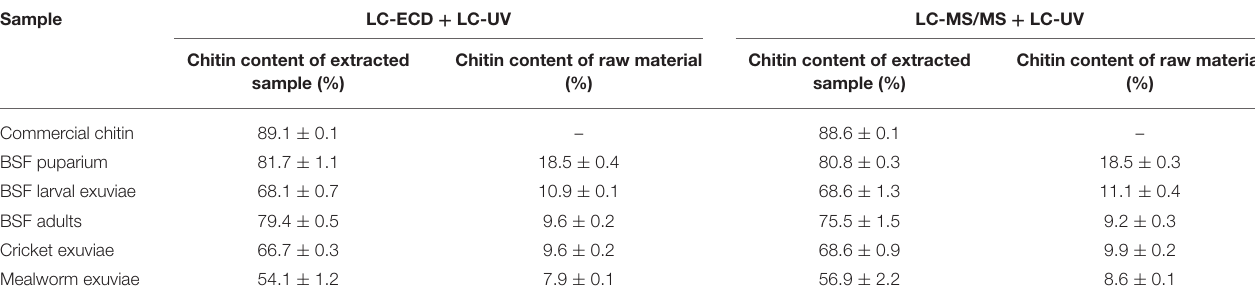
TABLE 5 | Chitin content of the extracted samples (%) and the estimated chitin content of the raw materials (%) based on the obtained LC data. Sample LC-ECD + LC-UV Chitin content of extracted sample